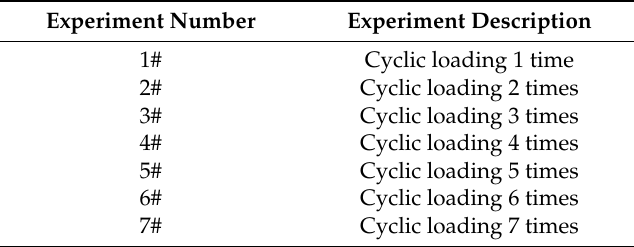
Table 1. Experiment design .